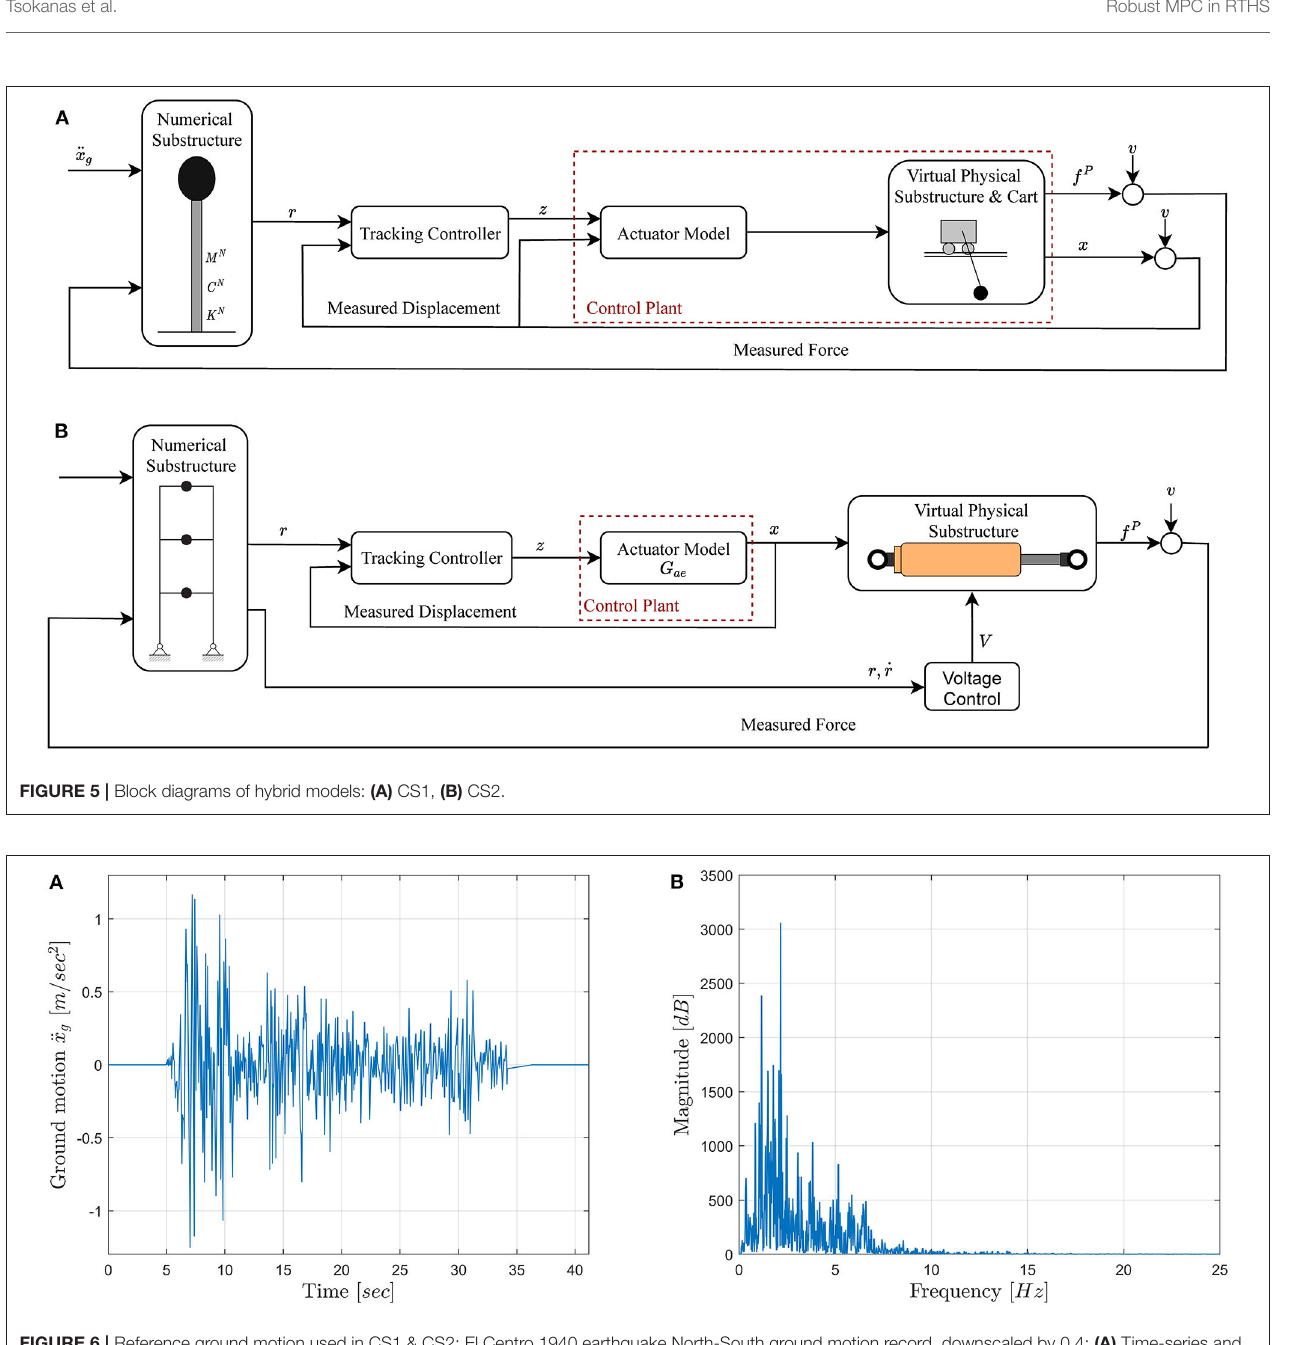
FIGURE 6 | Reference ground motion used in CS1 & CS2; El Centro 1940 earthquake North-South ground motion record, downscaled by 0.4: (A) Time-series and (B) Power spectral density of the respective